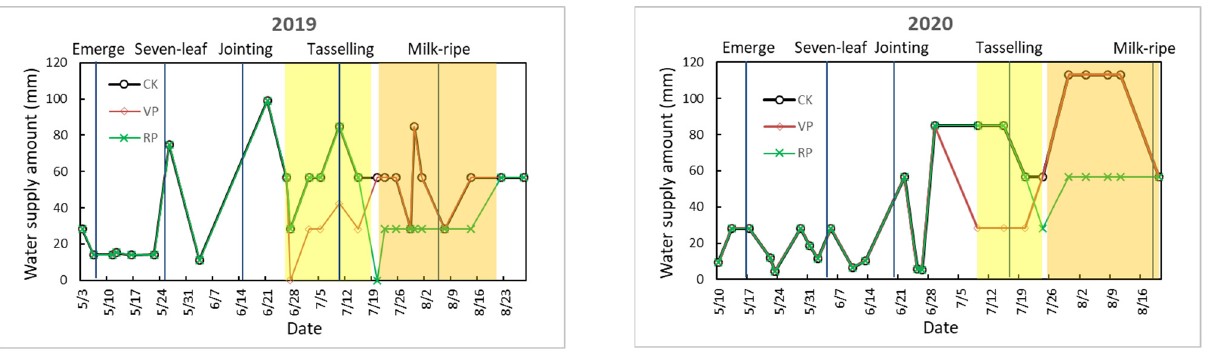
Figure 1. Dates (month/day) of maize growth periods and irrigation regimes for the different ex- perimental treatments in 2019 and 2020. The light and deep yellows stand for the periods of VPWC and RPWC, respectively.